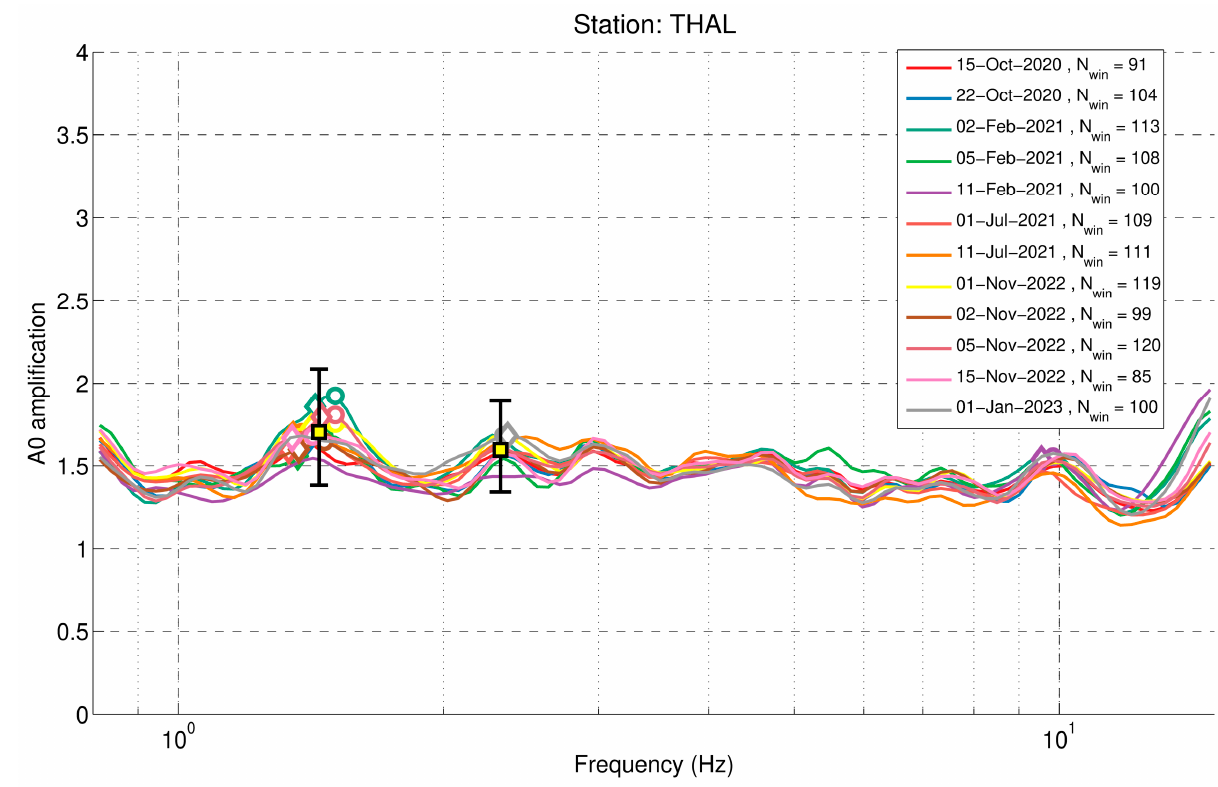
Figure 13. Average HVSR curves (solid lines) determined for station THAL on different days, from 60 s long windows selected after the application of STA/LTA anti-triggering on 6 h long records. Circles denote the global frequency on each curve, while diamond symbols mark the average of the frequency band denoting the range of peak frequencies of the HVSR lines from the individually selected windows (light/dark gray band in Figure 2b). Squares mark the prominent global and secondary peak frequencies recognized from the HVSR spectra, with error bars indicating the uncertainty of the amplification factor (Table A1).